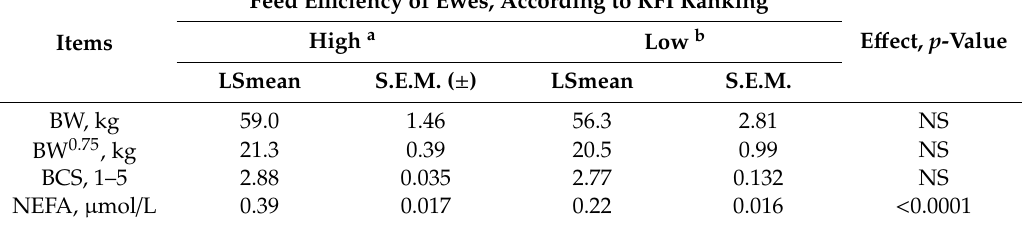
Table 4. Relationships between residual feed intake (RFI) and average total (BW) or metabolic body weight (BW 0.75 ), body condition score (BCS), and plasma non-esterified fatty acids (NEFA) profile in individually fed primiparous Lacaune dairy ewes at mid-lactation (42–98 DIM). Ewes were classified